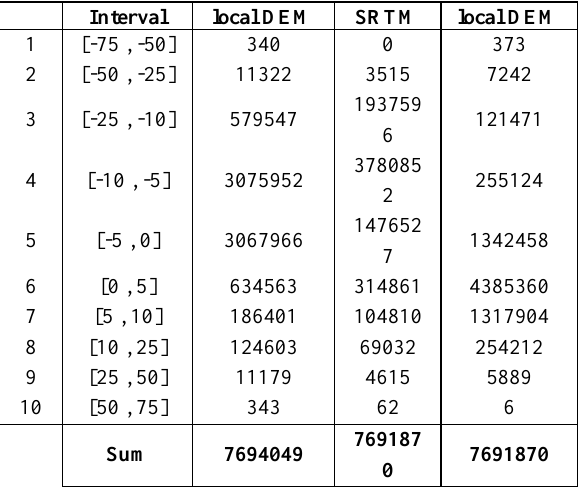
Table 4. Classification of the height errors in three datasets Classification of Height Difference Images in